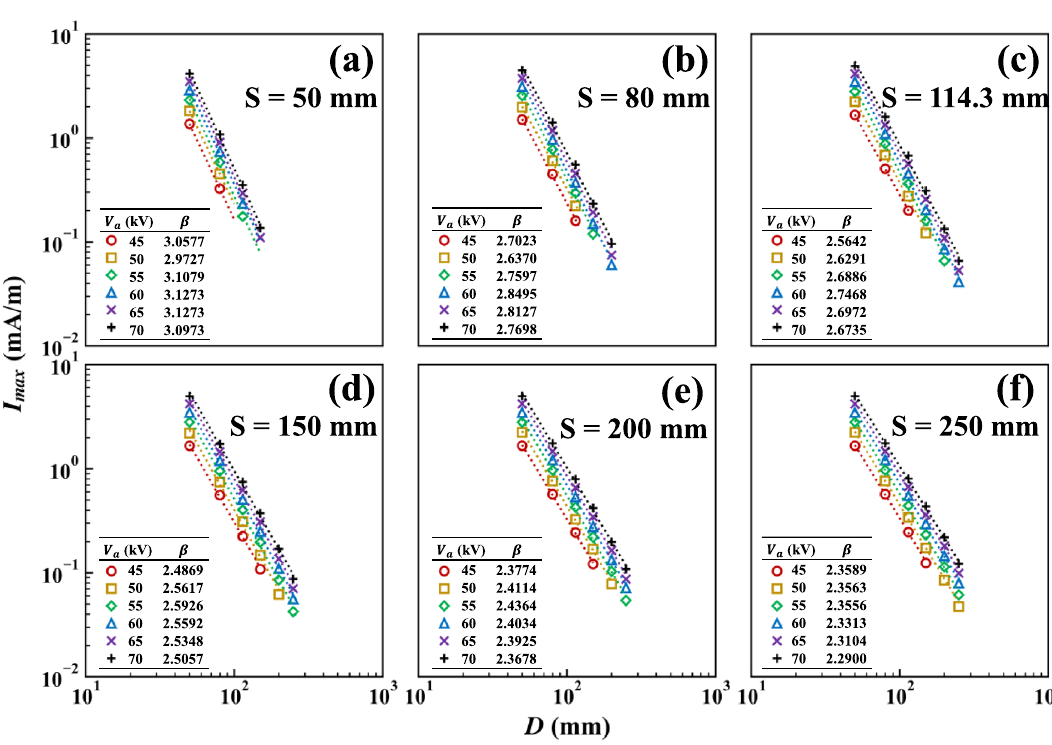
Figure 7. I max for various D , S , and V a